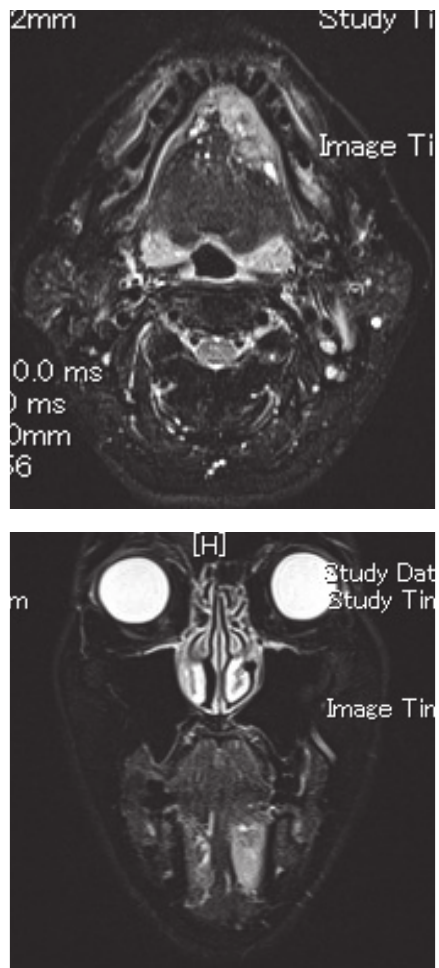
Figure 2: MR images (STIR) showed a well-defined tumor of the sublingual gland with a high-signal mass measuring 28 × 25 × 12